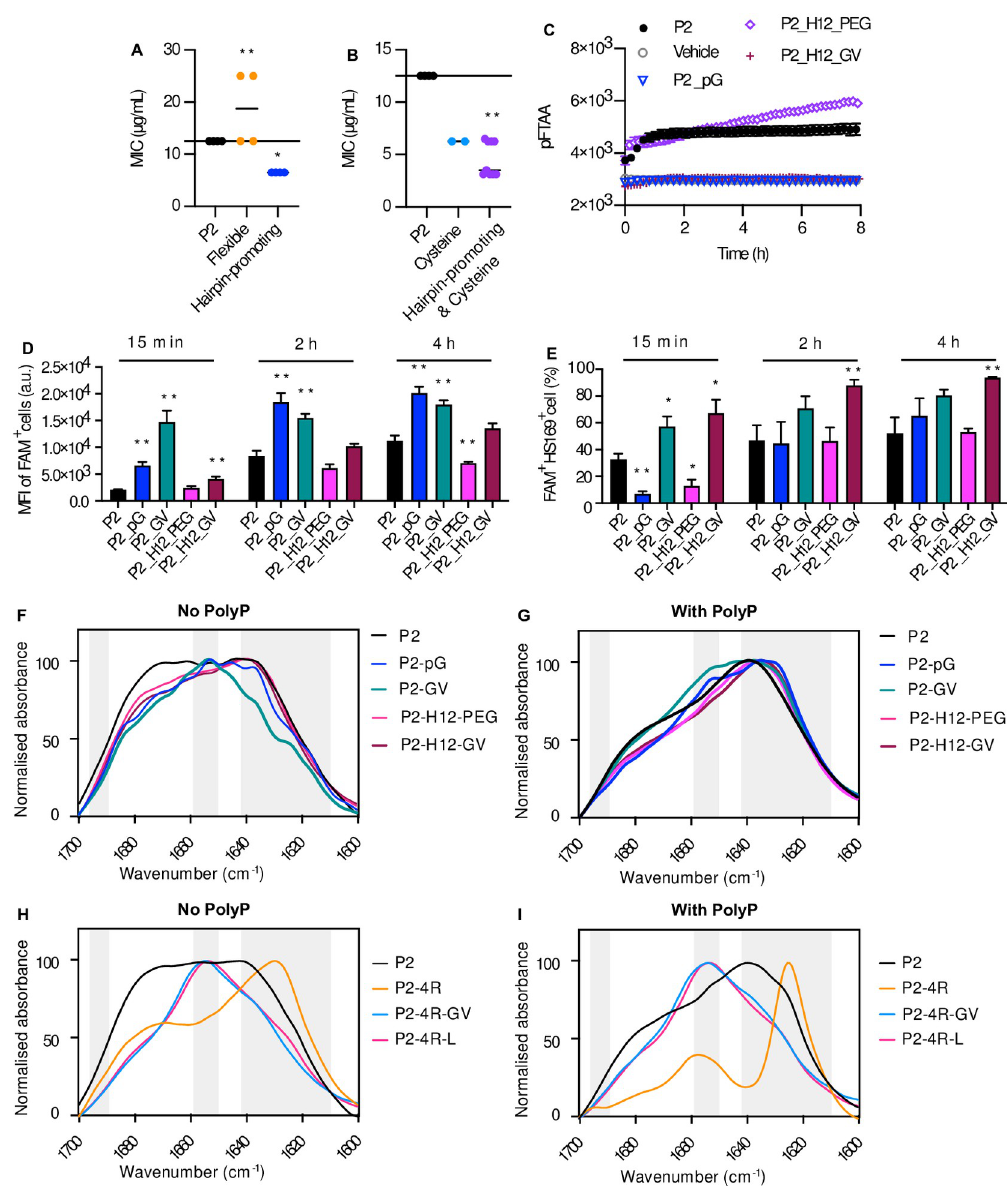
Fig 4. Beta-hairpin promoting motifs can improve antimicrobial potency. A-B: MIC of P2 variants generated by linker modification ( A ) or cysteine addition ( B ) against E . coli BL21. These two figures are associated with data from S7 and S8 Tables, respectively. Each dot represents the MIC of one Pept-in design. C: Time dependence of pFTAA (0.5 μ M) fluorescence intensity of P2 derivatives (50 μ M) in the presence of polyP (0.5 mM). (n = At least 3). D-E: Flow cytometry analysis of E . coli BL21 treated with FAM-labelled Pept-ins for different time points at FAM-P2-MIC from three independent experiments. Samples were acquired using BD Fortessa X-20. MFI of FAM positive cell population ( D ), and the percentage of FAM and HS169 positive cells ( E ) when treated with P2 and its derivatives with increased antimicrobial potency at the concentration of FAM-P2 MIC. Error bars represent SEM (n = 6). F-I: FTIR spectrum of P2 variants with altered linkers in PBS (6% DMSO), without ( F , H ) or with ( G , I ) the presence of PolyP. The absorbance is normalised between all samples and the spectrum is scaled to the amide I region between 1600–1700 cm − 1 . Peaks within the left (1689–1696 cm − 1 ) and right (1610–1642 cm − 1 ) grey bar are assigned to β -sheet, while peaks within the grey bar in the middle (1651–1659 cm − 1 ) is assigned to α -helix. The FTIR spectrums are representative of three independent experiments. For A-B , one-sample Wilcoxon signed-rank test was used to compare the MIC median of each Pept-in group to P2 MIC (12.5 μ g/mL). For D-E , a two-tailed Student t-test was performed for calculating statistical significance between the mean of P2 variant and P2. Asterisks indicating the level of the p value centred over the error bar mean: * p < 0.05, ** p < 0.01, *** p < 0.001, and **** p <